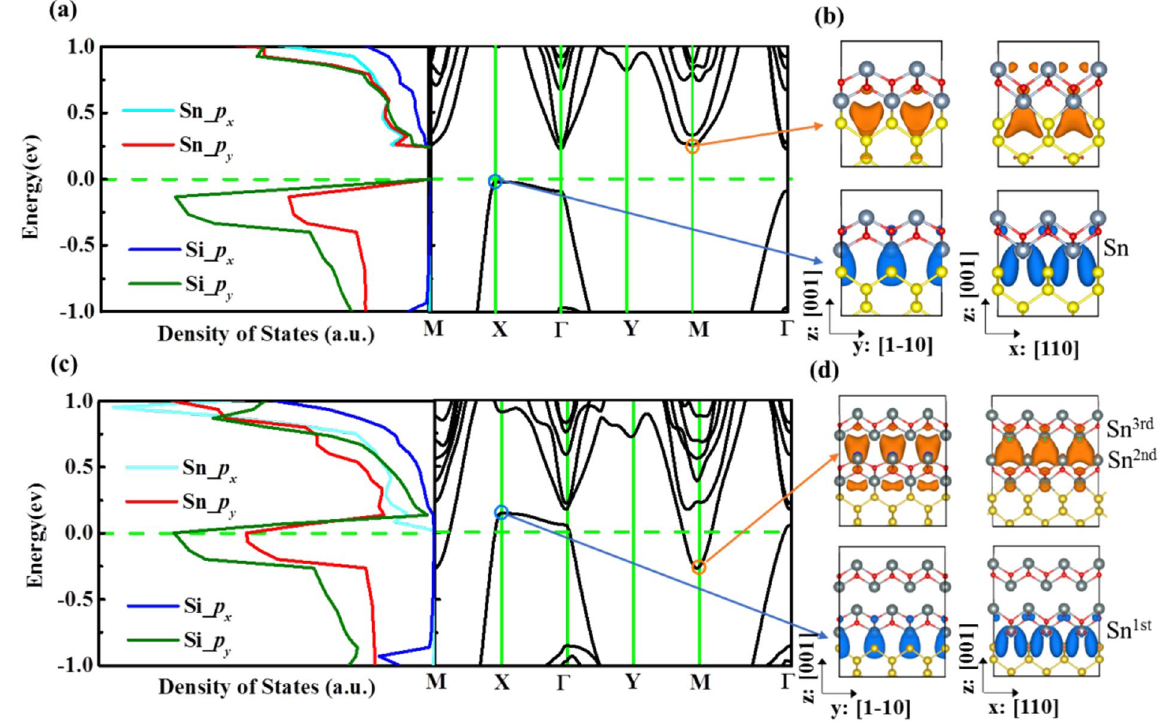
Figure 3. The density of states (DOS) and band structures for ML-SnO/Si(001) ( a ), along with the corresponding charge density at the CBM (M point) and VBM (X point) ( b ). DOS and band structures for BL- SnO/Si(001) ( c ), along with the corresponding charge density at M and X points ( d